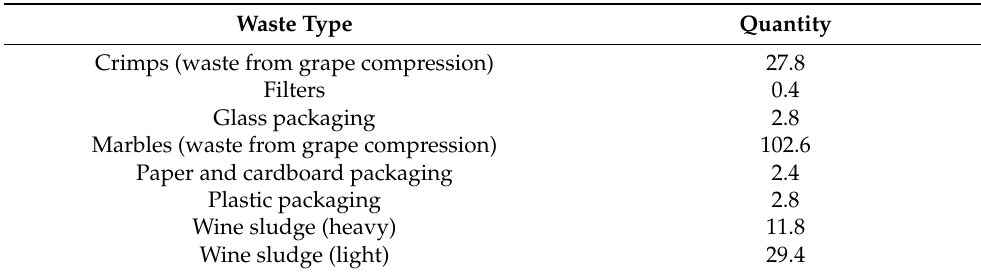
Table 1. Wineries’ waste streams (in tonnes per year) 1